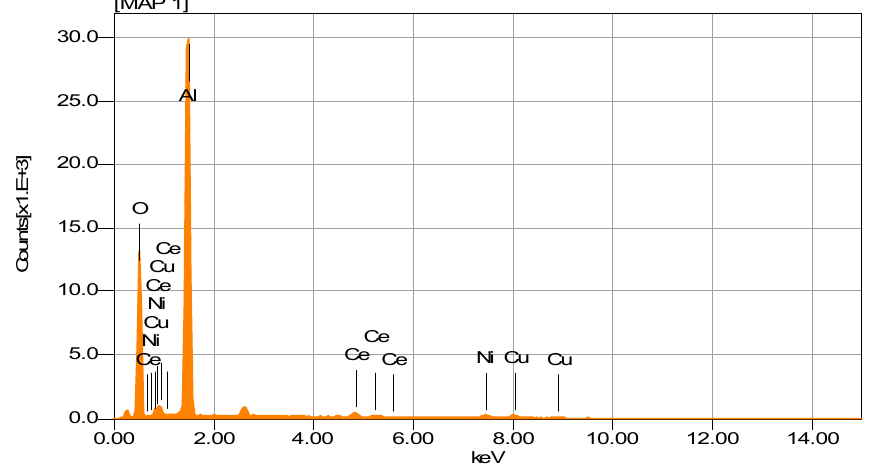
Figure 9. EDS spectrogram of NiCuAlCe bimetallic-supported catalyst. The elemental mapping of NiCuAlCe is shown in Figure 10. The result indicated that Ni and Cu atoms were mostly distributed uniformly over the entire set of NPs, but in the center of the sample, Cu atoms were